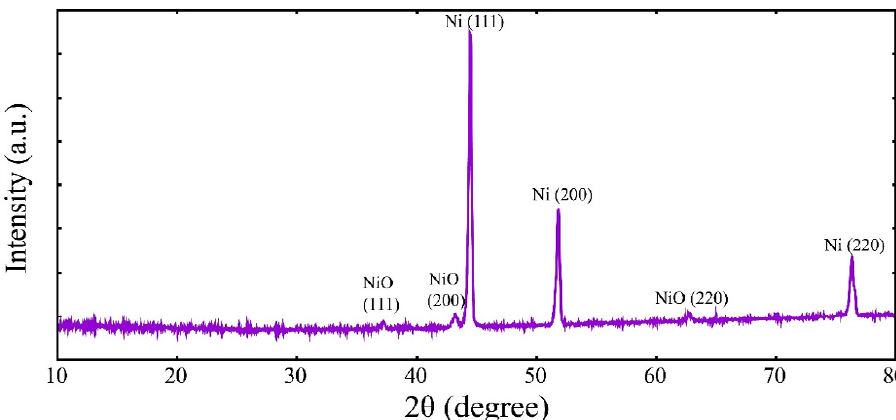
Figure 5 Fig. 5. The XRD pattern of the electrode fabricated at 400 °C.